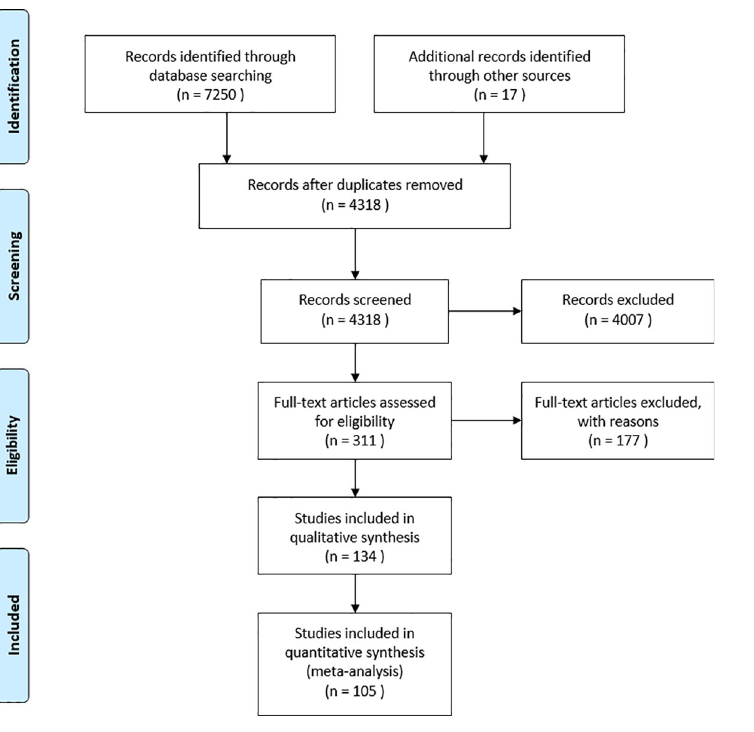
Fig 1. PRISMA flow